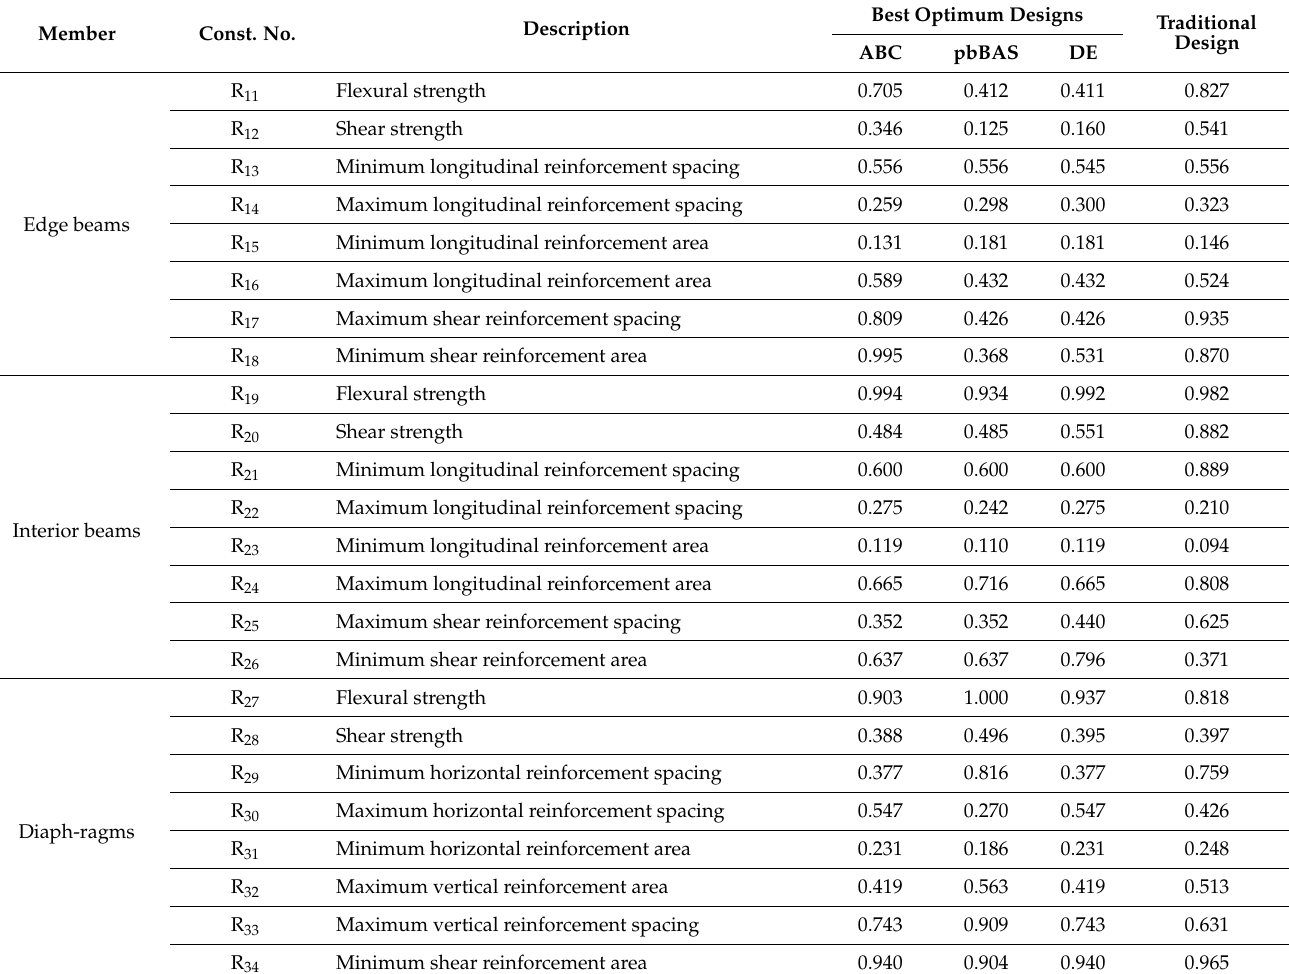
Table 28. The maximum demand capacity ratio of auxiliary members’ constraints in the optimum de- sign achieved by each metaheuristic algorithm for the three-segment type folded plate roof building. Const.